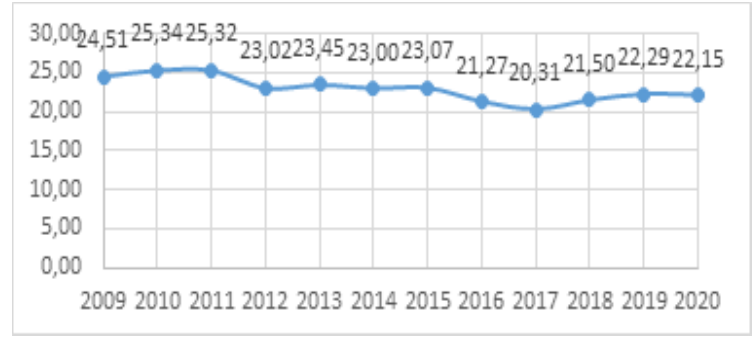
Figure 10: RCA Value Development in Thailand 2009-2020